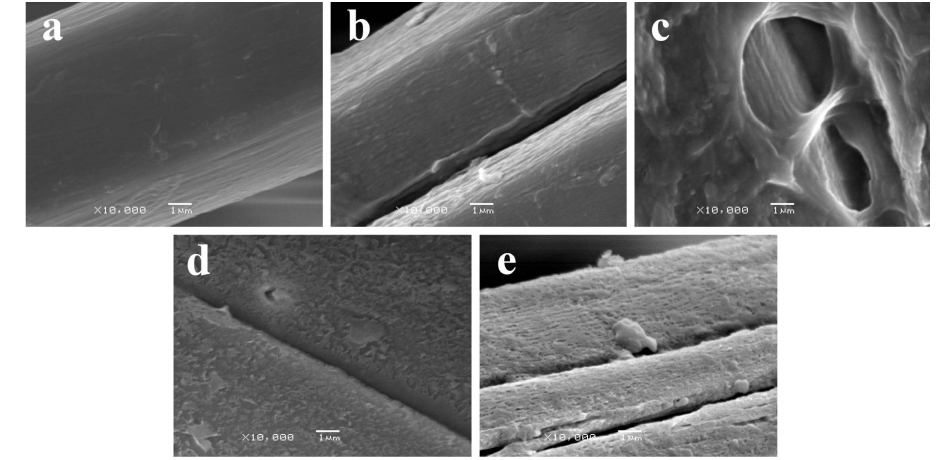
Figure 6. Comparative SEM images taken at 10 kV and ˆ 10,000 magnification, of the surfaces of samples ( a ) NW C-Ar5; ( b ) NW C-Ar5-Et5; and ( c ) NW C-Ar5-Et10; and ( d ) NW C-Cr1010; and ( e ) NW C-Cr1010-Et10.